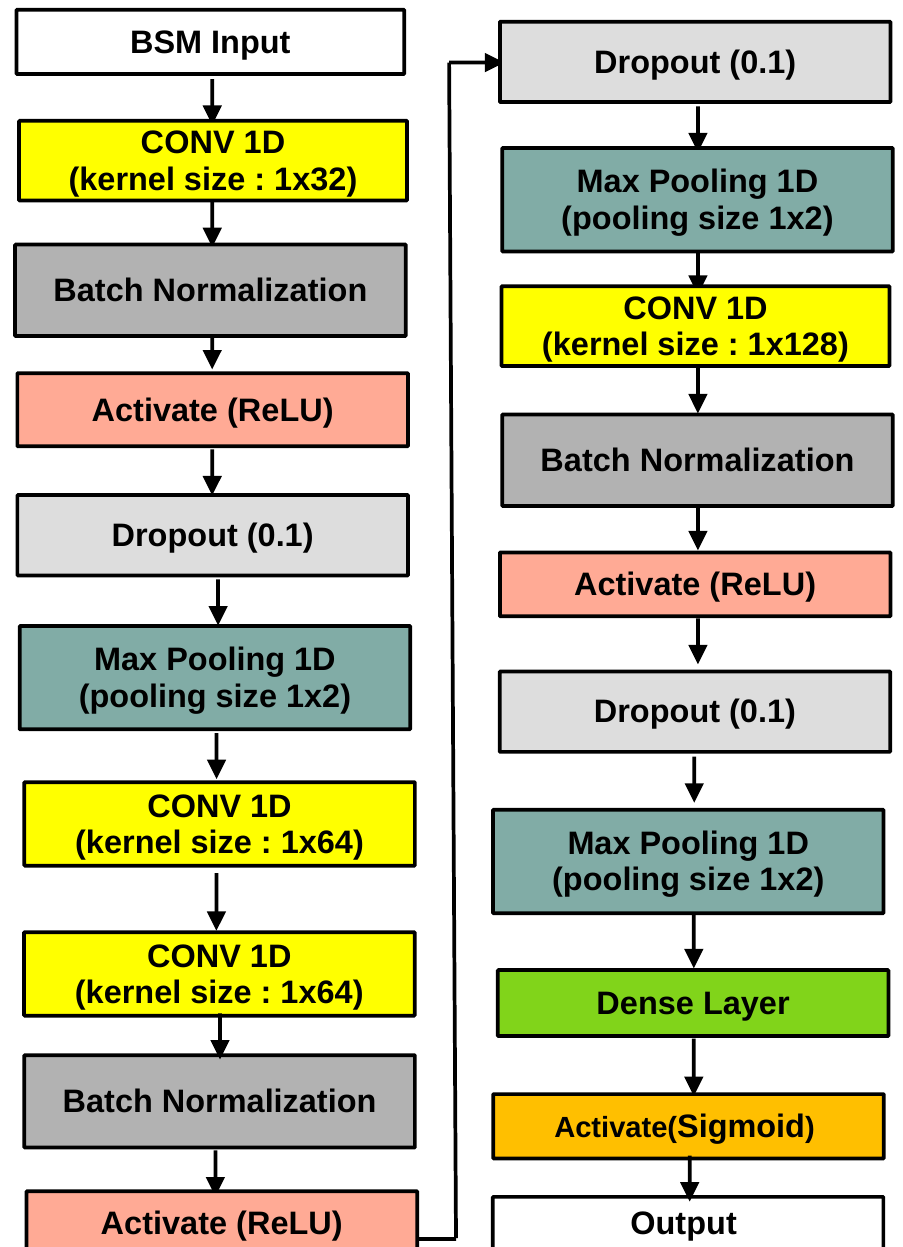
Figure 4. 1-Dimensional Convolutional Neural Network